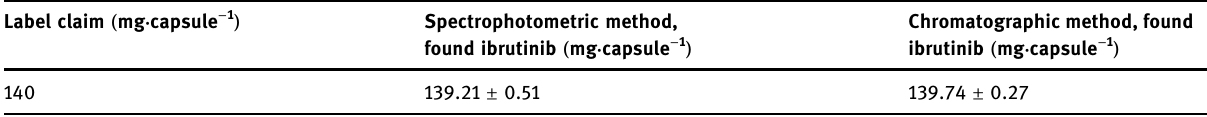
Table 6: Analysis results of the marketed pharmaceutical formulation